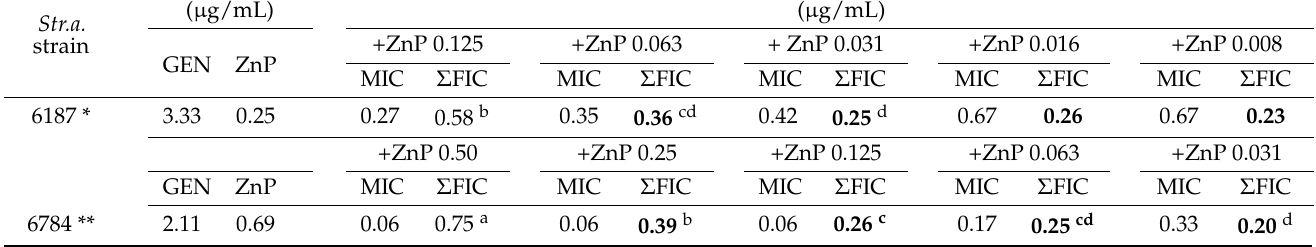
Table 1. In vitro inhibitory activity of zinc pyrithione/gentamicin combinations against Streptococcus agalactiae strains.